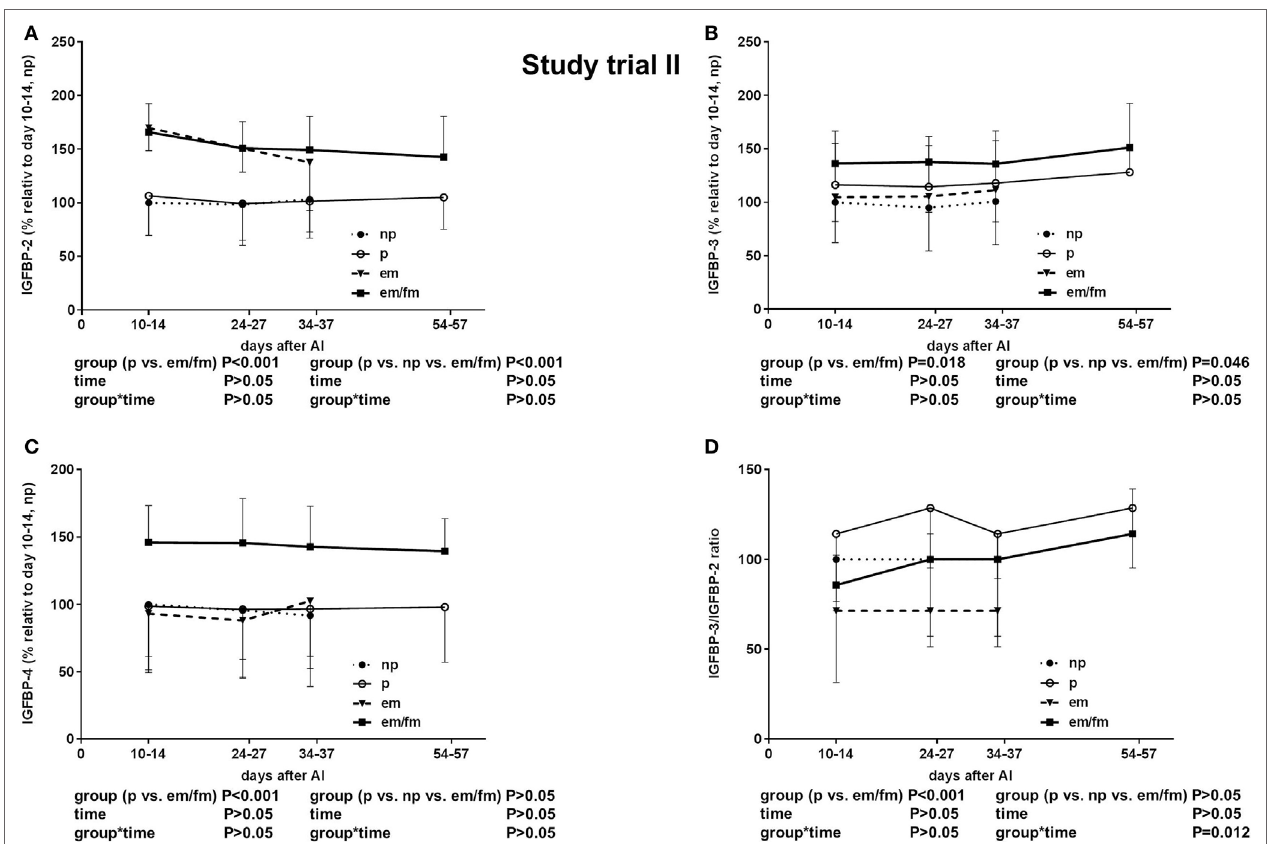
FigUre 4 | Study trial II: insulin-like growth factor-binding protein (IGFBP) (a) : -2. (B) : -3. (c) : -4 and (D) : IGFBP3/IGFBO2 ratio in non pregnant (np, n = 20) and pregnant (p, n = 30) Holstein Friesian cows and cows with embryo mortality (em, n = 7) between days 24-27 and 34-37 or late embryo mortality/early fetal mortality (em/fm, n = 8) between days 24-27 and 54-57. Values are given in percentege relative to days 10–14 of non-pregnant cows. Values are given as mean ±